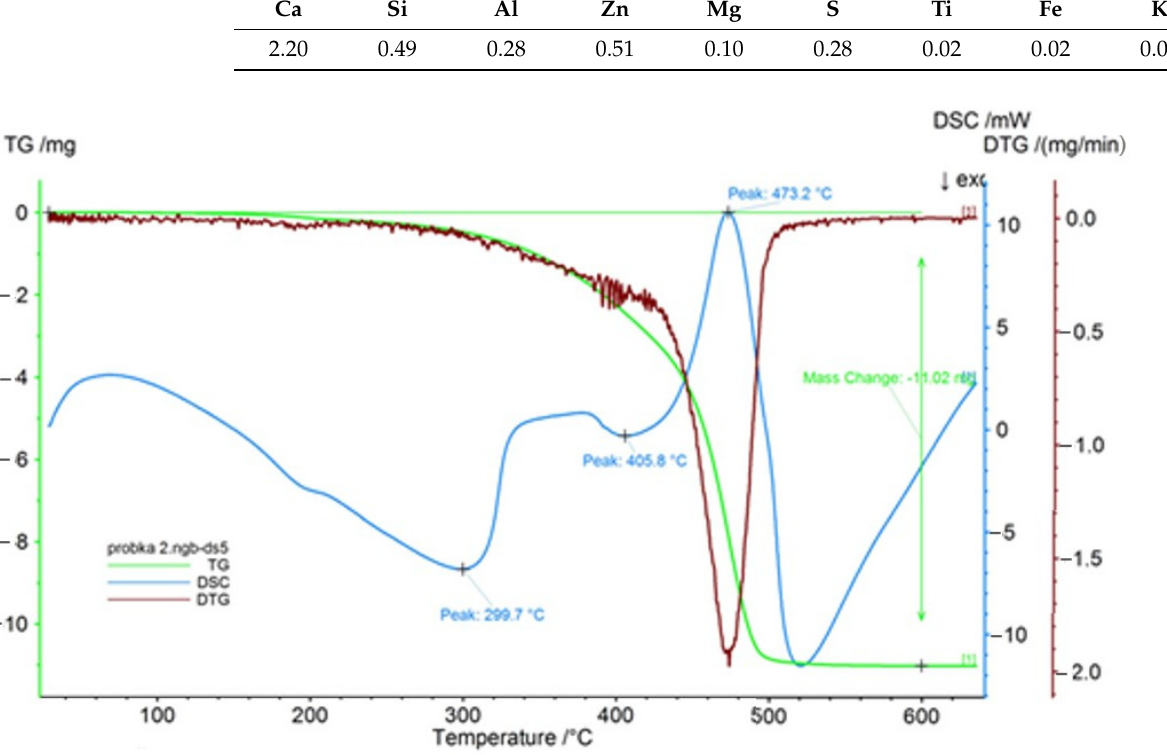
Figure 2. TGA − DTA thermogram for the waste thermoplastic